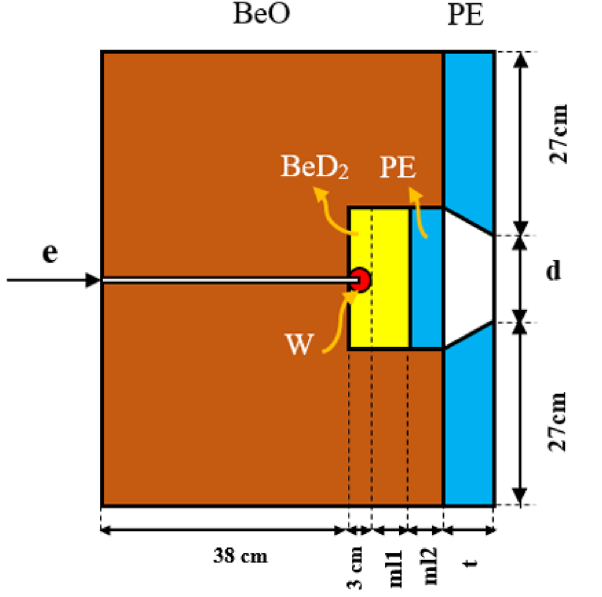
Figure 1. The primarily-proposed TD 21